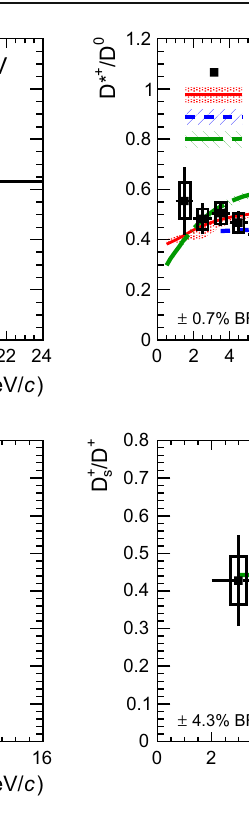
extrapolating the visible cross section to the full p T